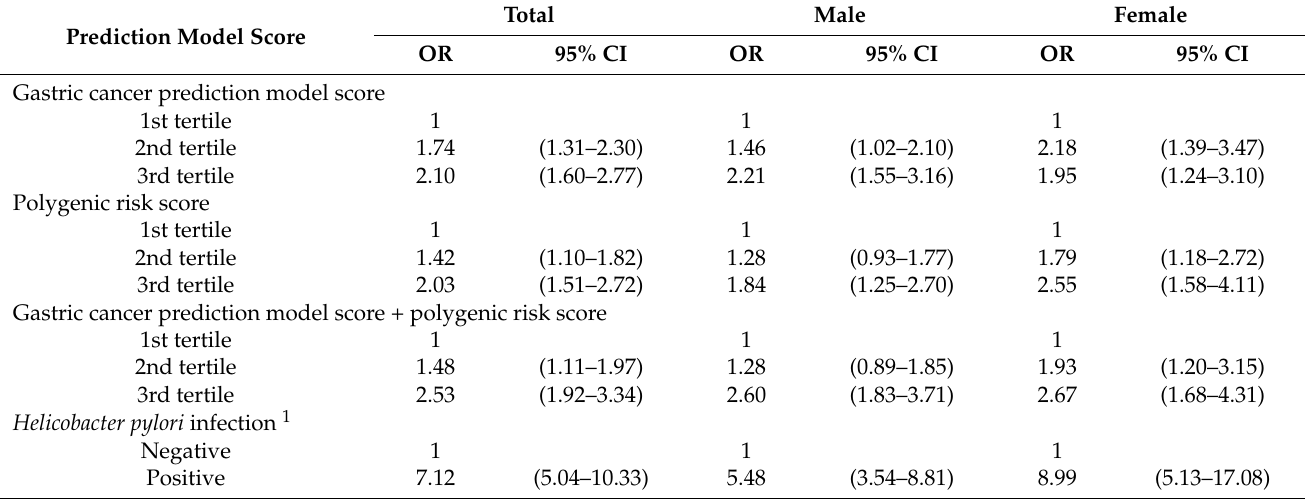
Table 2. Association of tertiles of gastric cancer prediction model score, polygenic risk score, Helicobacter pylori infection, and gastric cancer. Prediction Model